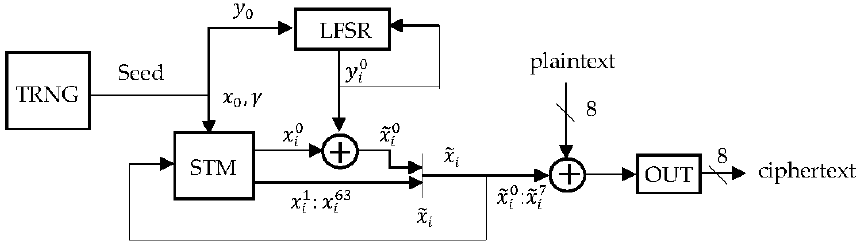
Figure 3. Block diagram of the proposed cipher system.